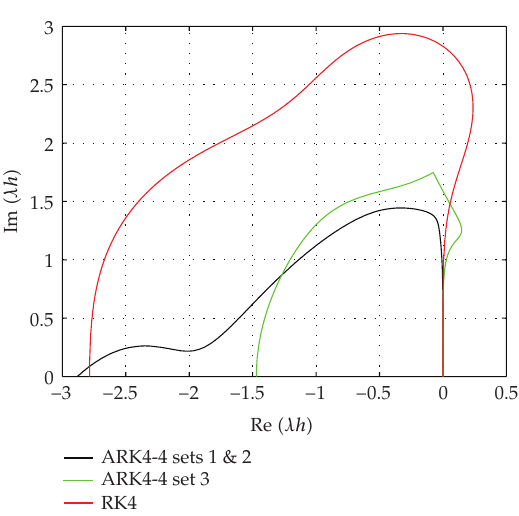
Figure 17: Stability region of ARK4-4 sets of Table 3 and RK4 set of Table 5.